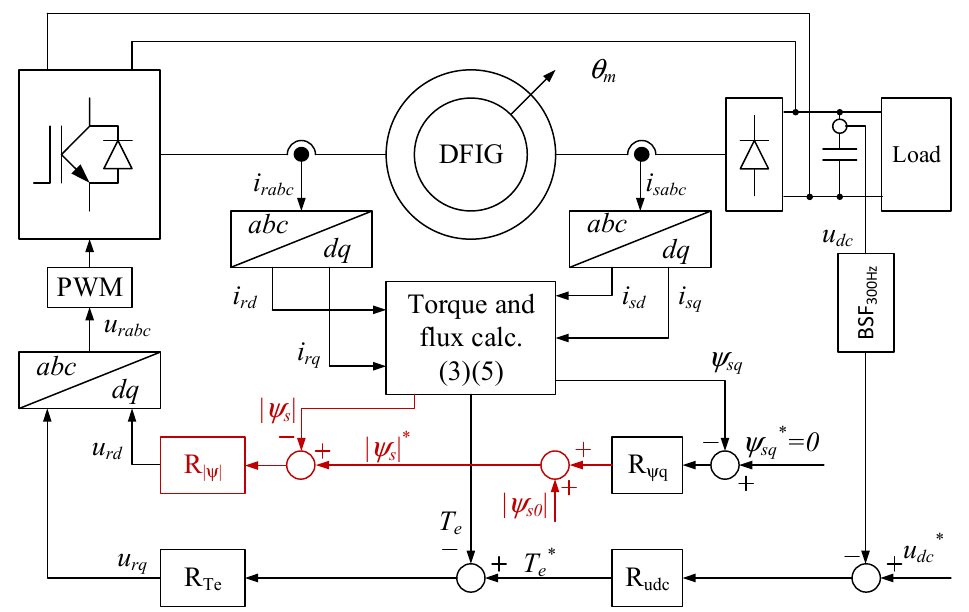
Figure 3. Stand-alone DFIG-DC voltage generator controlled with direct torque and flux module control DT Ψ C.